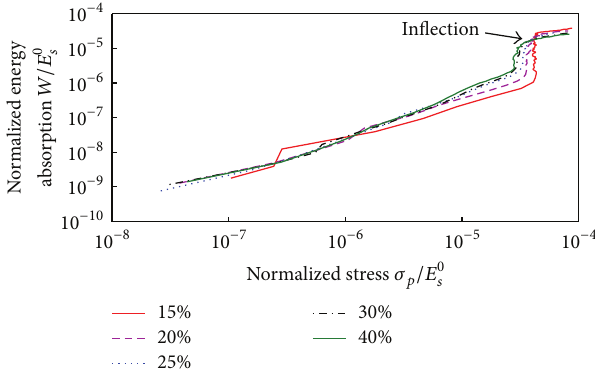
Figure 6: Energy absorption curve ( 𝑡/𝑙 = 0.0263 ) 𝑛 = 10000 .